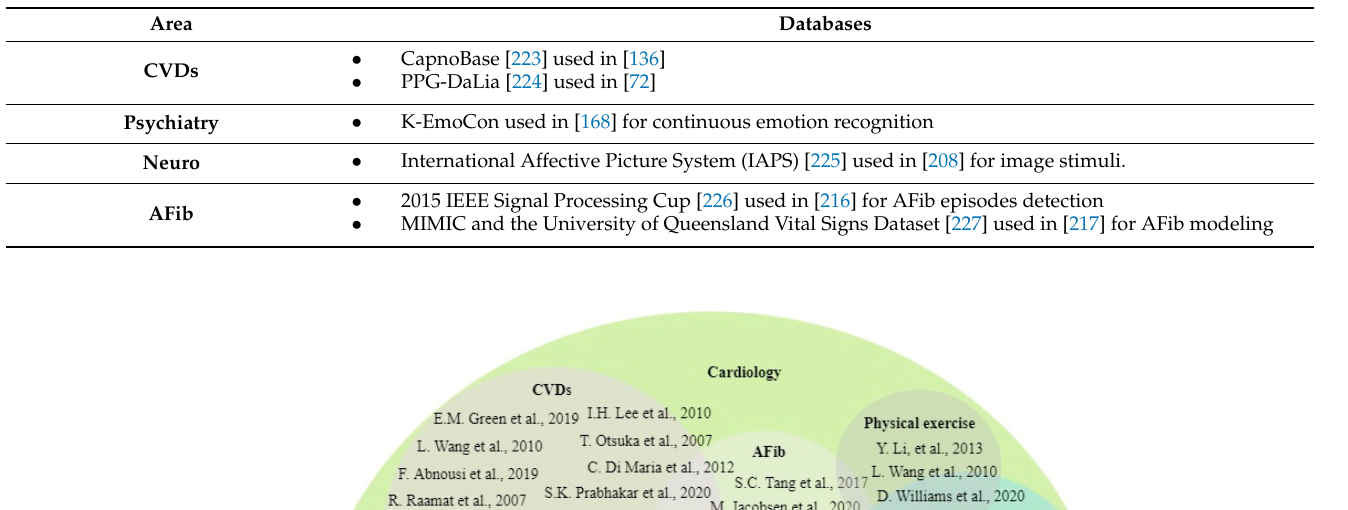
Table 5. Public datasets of PPG signal used in the literature.